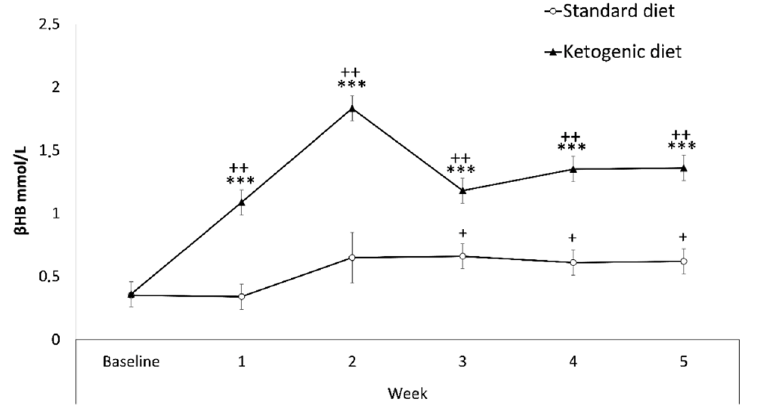
Figure 2. Weekly β-hydroxybutyrate blood levels. Data are represented as the mean (±SEM) amount of βOHB measured weekly. *** p < 0.001 significant difference with respect to SD group. ++ p < 0.001; + p < 0.05 significant difference with respect to the baseline.